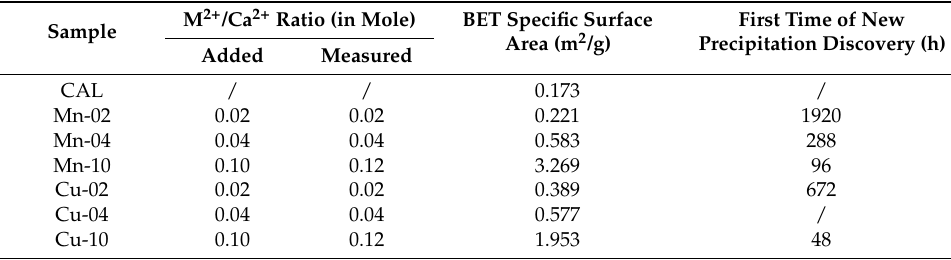
Table 1. Composition, Brunauer–Emmett–Teller (BET) specific surface area of the solid solutions, and first time of new precipitation